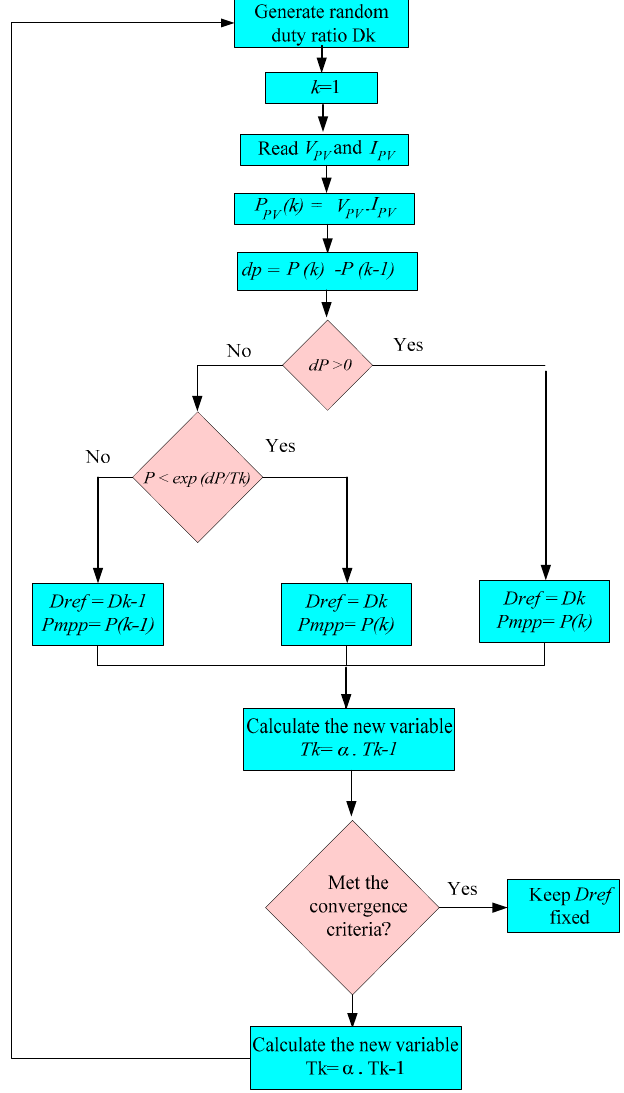
Figure 11. Flowchart of the SA technique.